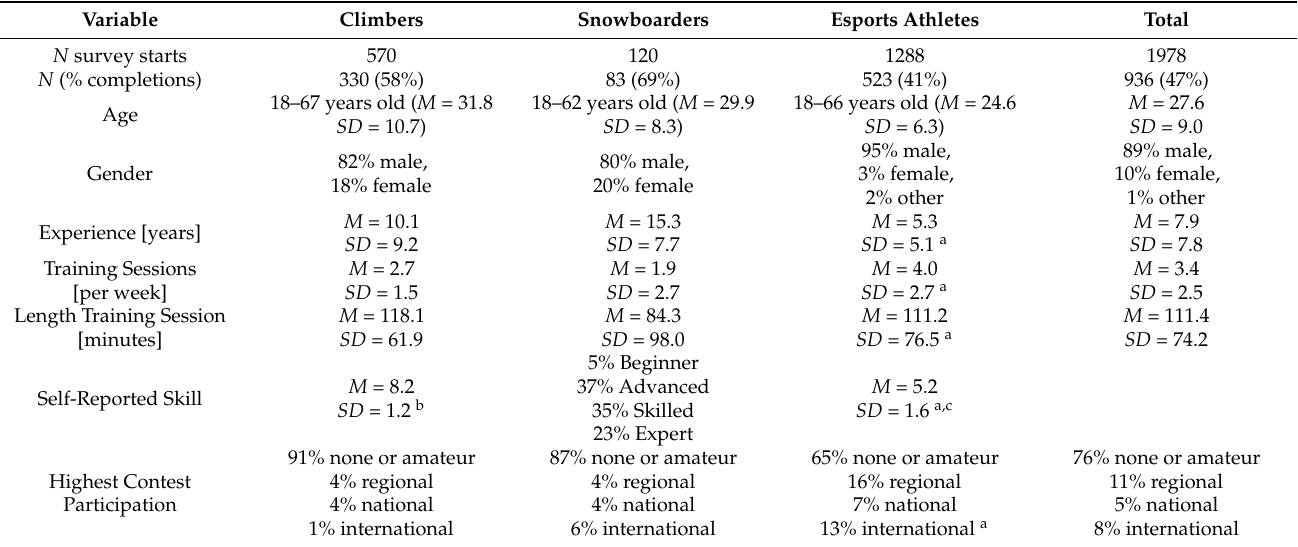
Table 1. Participant flow, basic demographics, experience, training schedule, and skill as a function of